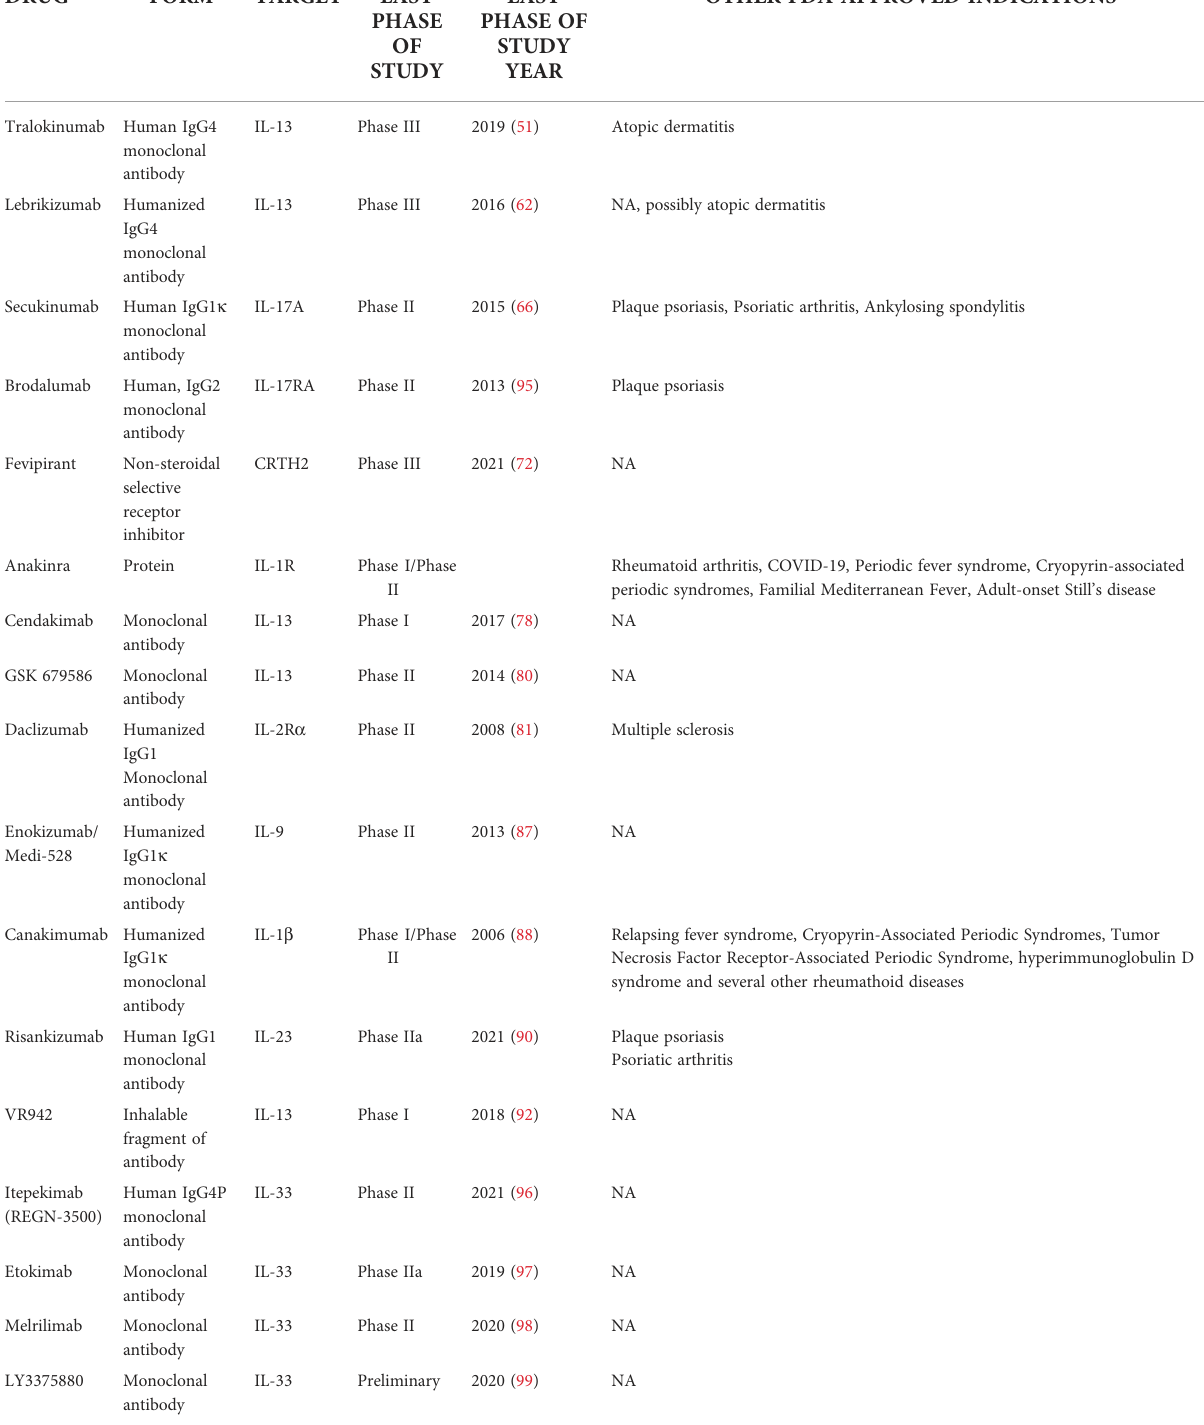
TABLE 2 Drugs discontinued in severe asthma research.